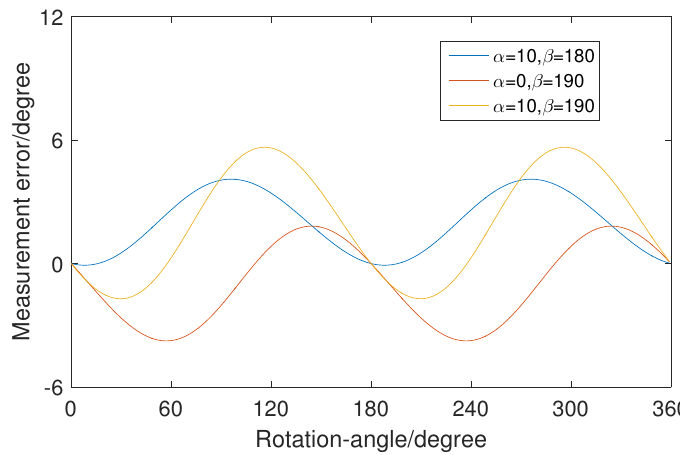
Figure 13. Measurement error in the simulation experiment when the vector rotates around its starting